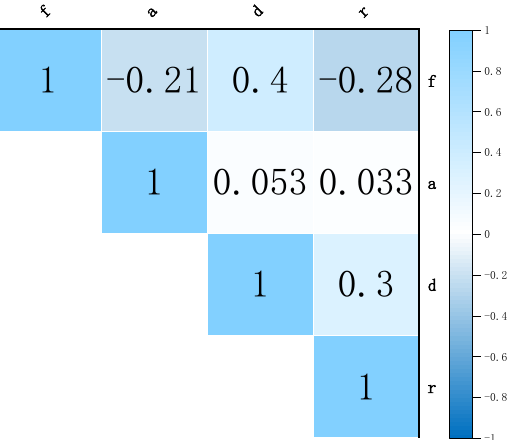
Figure 7. Thermal graph of sample feature correlation matrix. Table 4. Relevant mechanical indexes of concrete. Asterisk shows the Relevant mechanical indexes of concrete. More asterisk show more relevance.